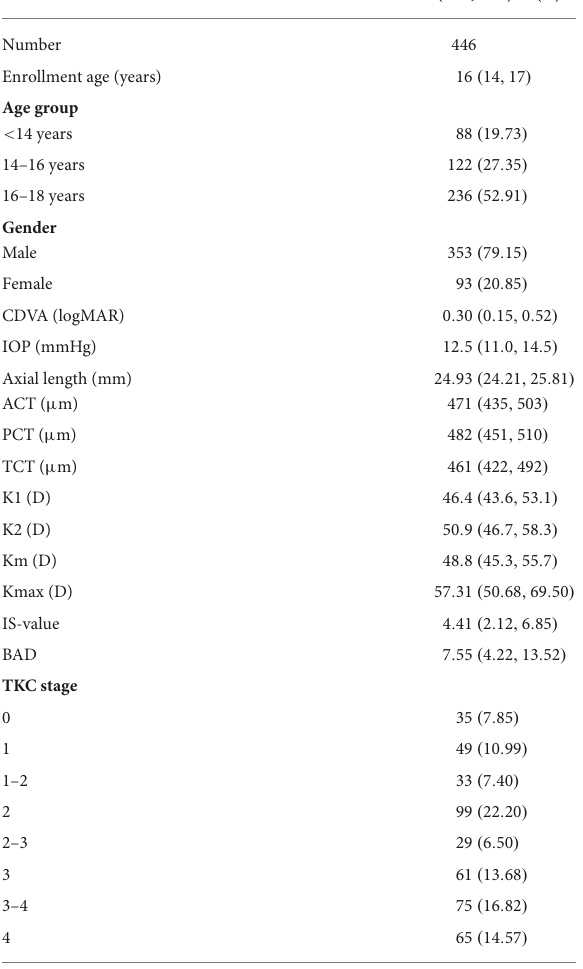
TABLE 1 The data characters of total pediatric keratoconus